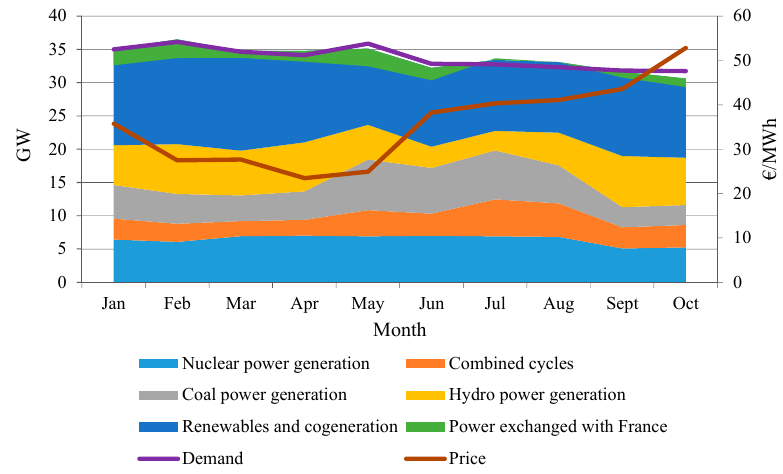
Figure 2. Monthly electricity generation, demand and real price of electricity in 2016.